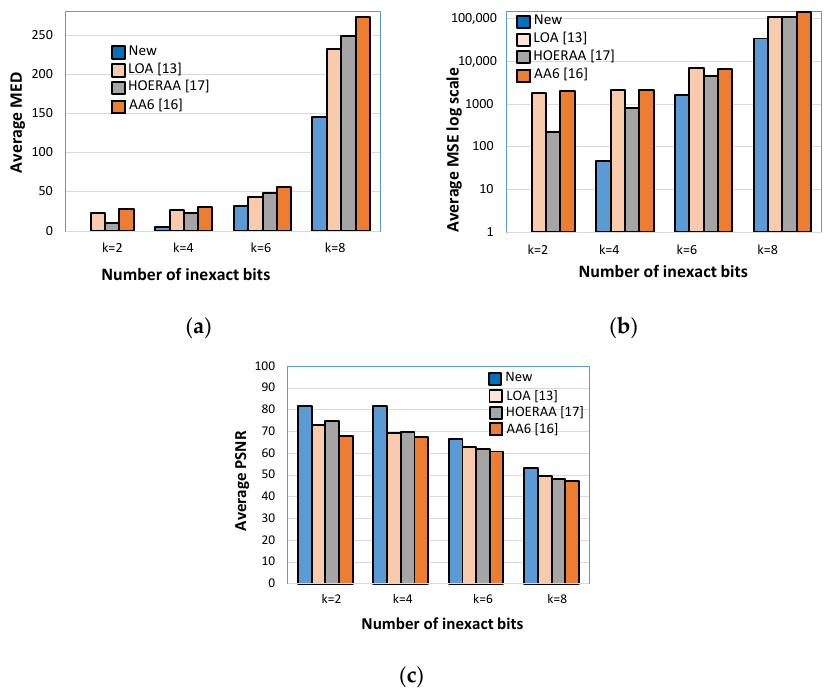
Figure 9. Accuracy results obtained for the Lena benchmark in terms of: ( a ) MED; ( b ) Mean Squared Error (MSE); ( c ) Peak Signal-to-Noise Ratio (PSNR).